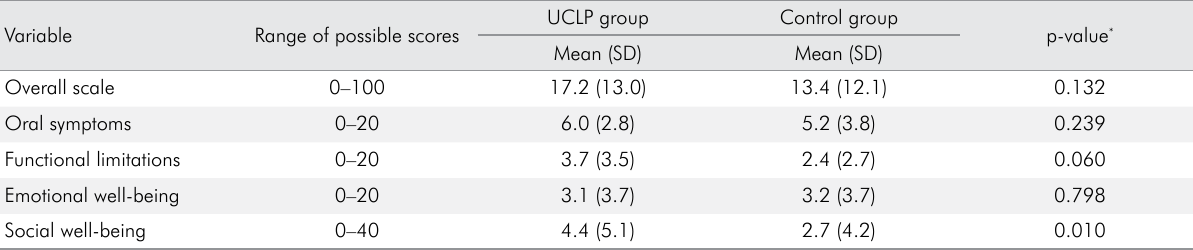
overall and domain scores between groups. 8-10